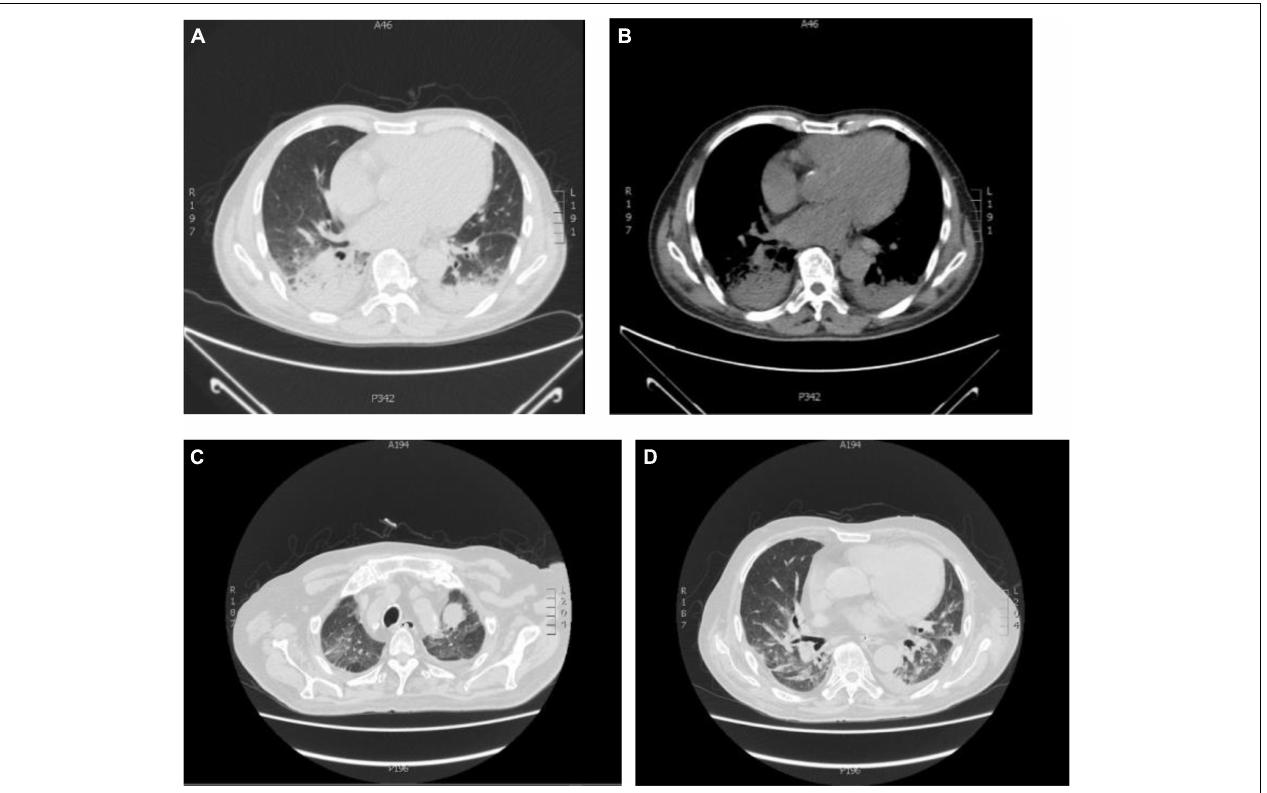
FIGURE 1 | Chest CT imaging findings in two admissions. (A,B) Dense patchy shadows in the dorsal segment of bilateral lobes and a small amount of pleural effusion on the right; (C,D) chest CT of this admission (the diagnosis of Nocardia infection). Bilateral interstitial inflammatory changes. Old lung and pleura lesions. Limited emphysema in both lungs. Left pleural effusion. Heart enlargement, pericardial effusion, and left neck and left lung apex mass shadow.